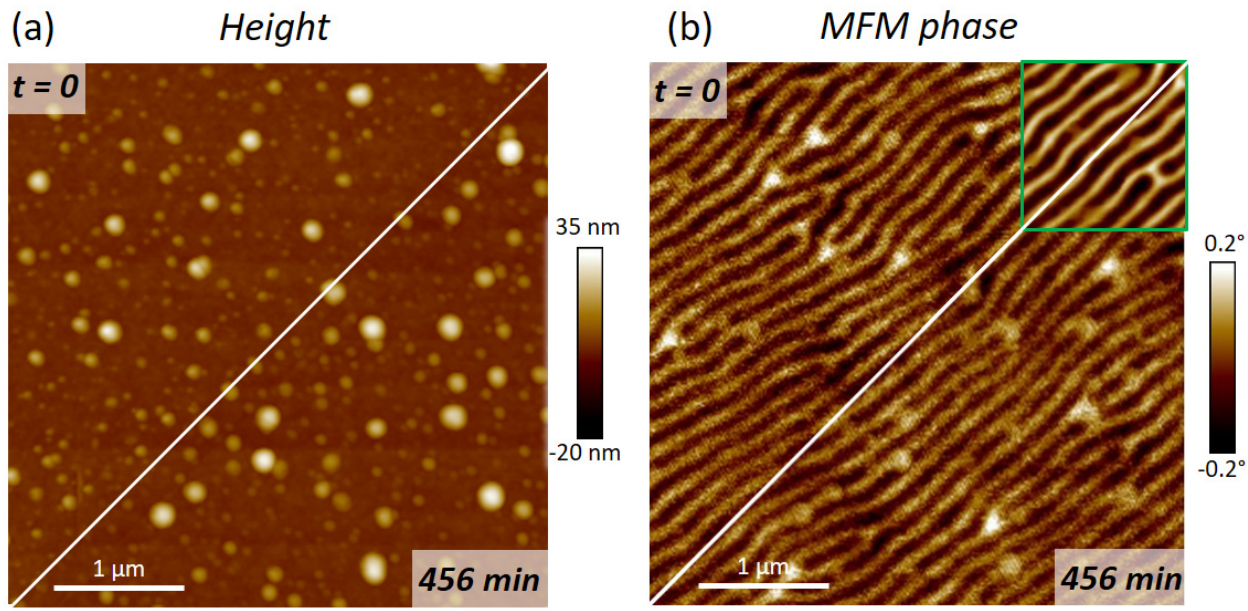
Figure 8. Wear testing of Co 3 Fe α -pillars, performed on a CoPt sample. The comparison shows the first and the last height image ( a ) and MFM-maps ( b ) after almost 8 h of continuous scanning along a distance of 46 cm. The green-framed box in ( b ) shows the high-quality MFM-maps, taken at 7 µ m/s while the scan speed was doubled for long-time measurements, which, together with a slightly increased lift-height, explains the higher noise in ( b ).